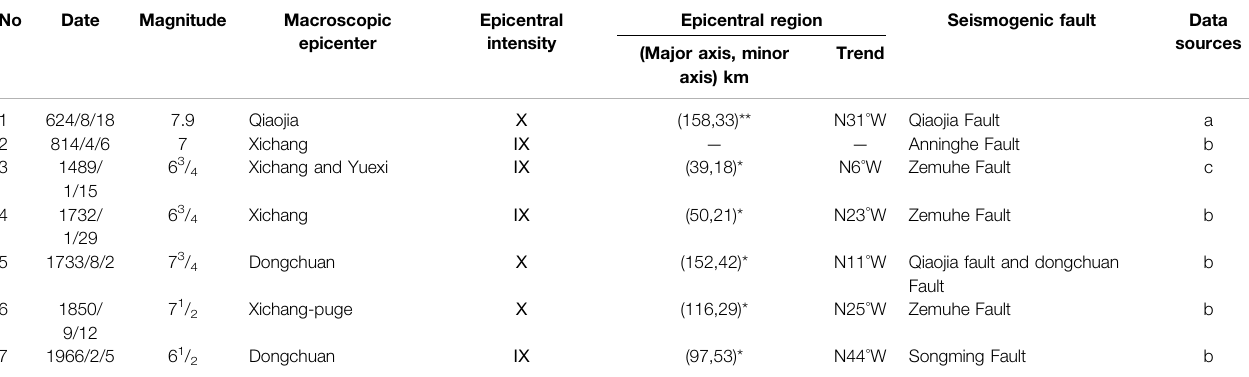
TABLE 5 | Parameters of earthquakes with intensity ≥ Ⅸ from Xichang to